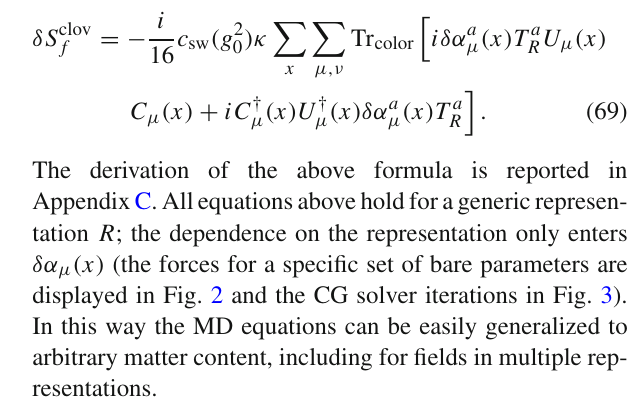
Fig. 2 Left panel: example of Monte Carlo history of the gauge force. Right panel: example of Monte Carlo history of fermionic forces in the fundamental and two-index antisymmetric representations are dis-